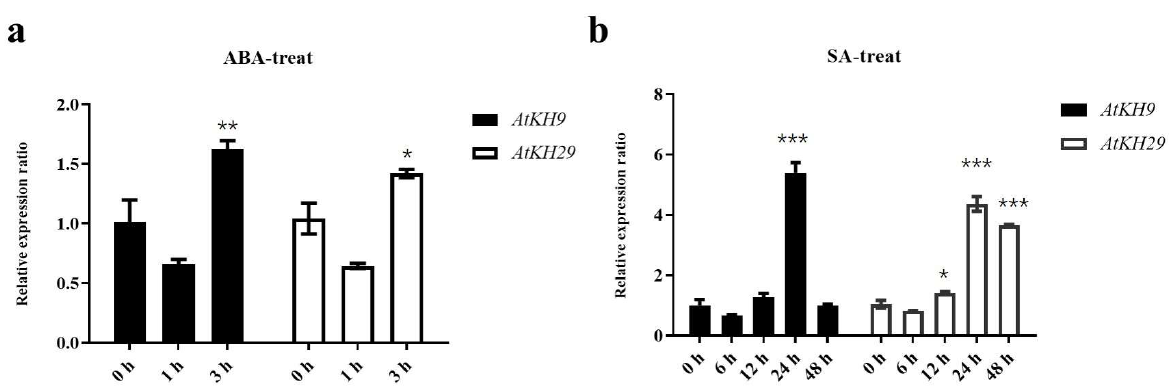
Figure 7. The expression levels of AtKH9/29. ( a ) AtKH9/29 expression levels at 0 h, 1 h, 3 h after ABA treatment. ( b ) AtKH9/29 expression levels 0 h, 6 h, 12 h, 24 h and 48 h after SA treatment. Error bars indicated SD. p value (* p < 0.05, ** p < 0.01, *** p < 0.001) was calculated using one-way analysis of variance and Tukey’s test for statistics.